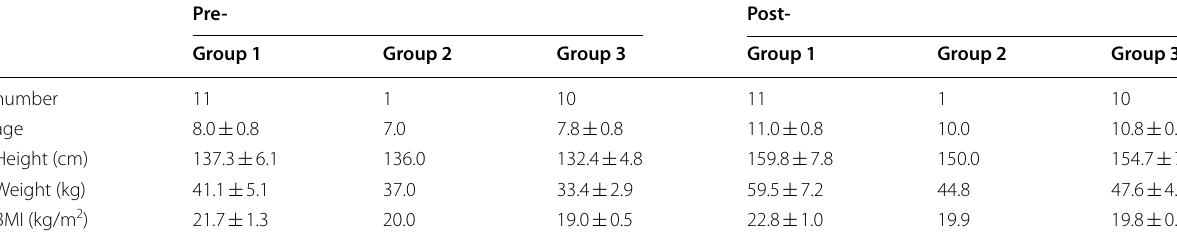
S.D.) of participants in weight-loss +